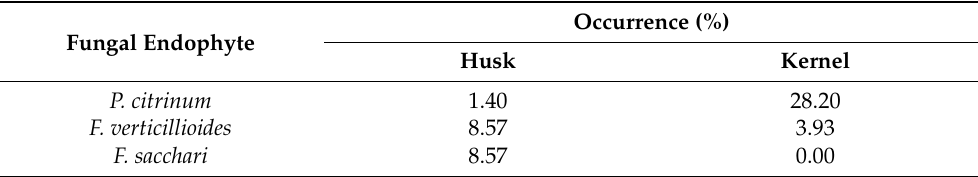
Table 1. The percentage occurrence of endophytic P. citrinum , F. verticillioides , and F. sacchari in healthy husk and kernel tissues of corn plants.